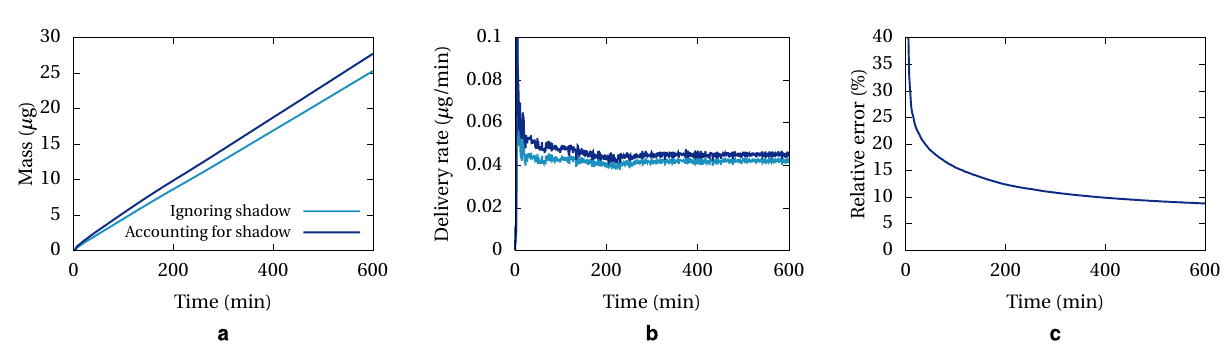
Figure 5. Delivery of methylene blue for a probe flow rate of 0.3 μL/min; ( a ) Mass measured in the image; ( b ) Delivery rate (time derivative of A); ( c ) Relative error when not accounting for probe